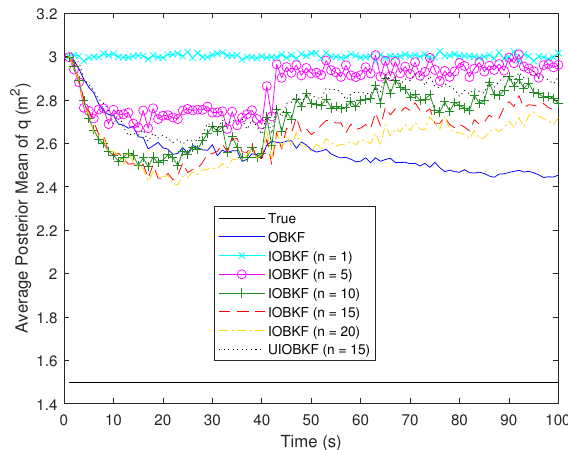
Figure 11. Estimation of noise parameter q .